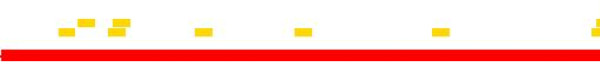
Schematics of zinc finger nucleases cleaving HPV type 16 genomic DNA. This figure offers a diagrammatic illustration of loci of action of zinc finger nucleases that target and cleave >18 bp (9x2 + 5, 6, or 7) sequences within the genomic DNA context of HPV type 16. Hits (blue, green, and gold bars) represent targets along the gene (red bars). ZFN hits in the graphic are color-coded on the basis of spacer size (5 bp = Blue; 6 bp = Green; 7 bp = Gold).